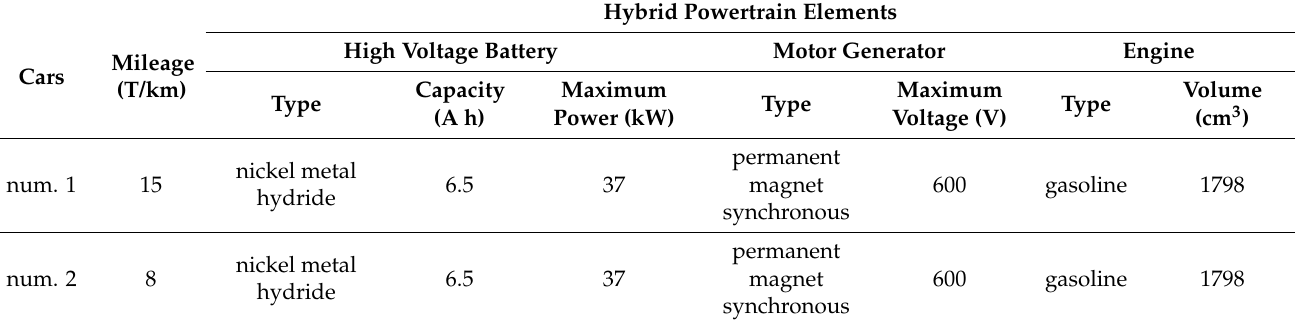
Table 2. Characteristics of cars.